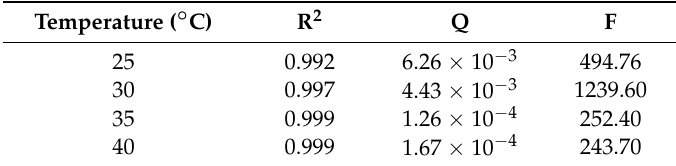
Table 2. Results of statistical tests of the proposed model for the photo-oxidation of RPE.